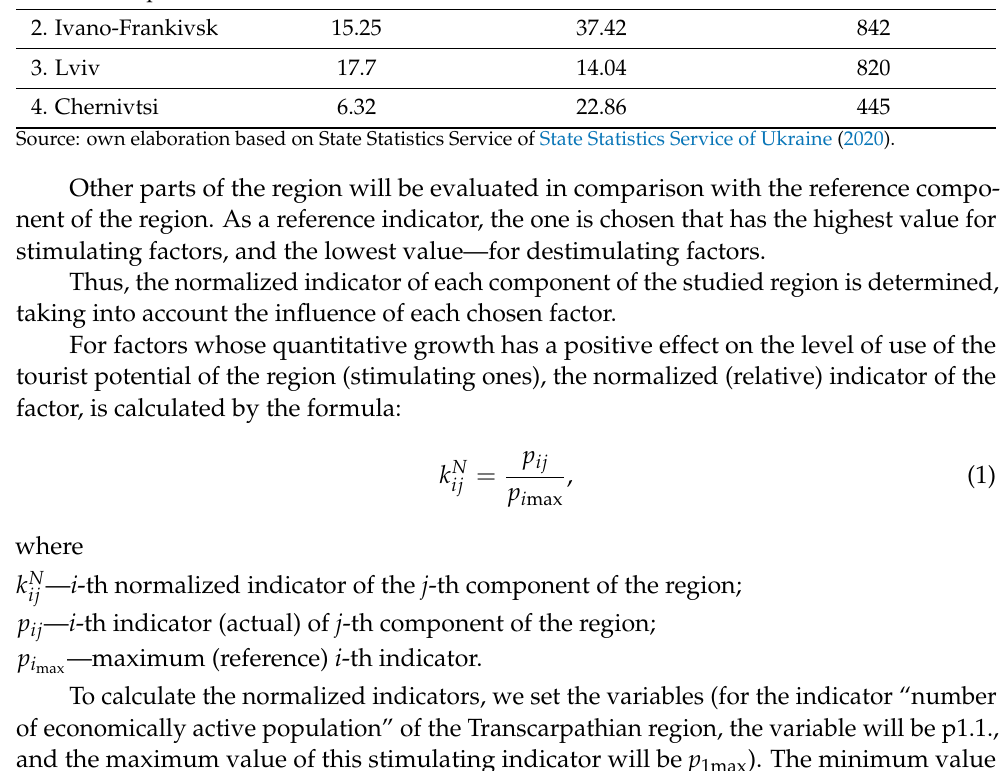
Amount of Amount of Tourist Area of Tourist Anthropogenic Tourist Accommodation, Resources, km 2 Resources, 100 Units